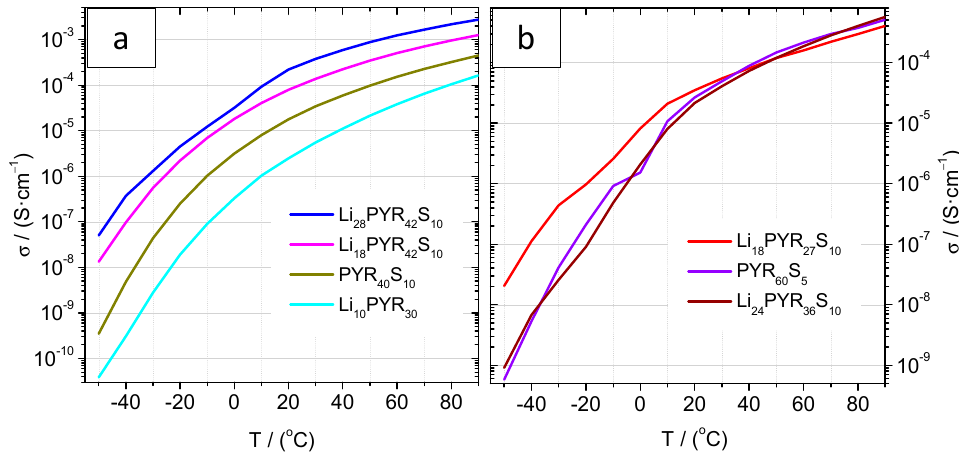
Figure 5. ( a ) σ (T) of electrolytes PYR 40 S 10 , Li 10 PYR 30 , Li 18 PYR 42 S 10 , and Li 28 PYR 42 S 10 and ( b ) σ (T) of electrolytes Li 18 PYR 27 S 10 , PYR 60 S 5 , and Li 24 PYR 36 S 10 .